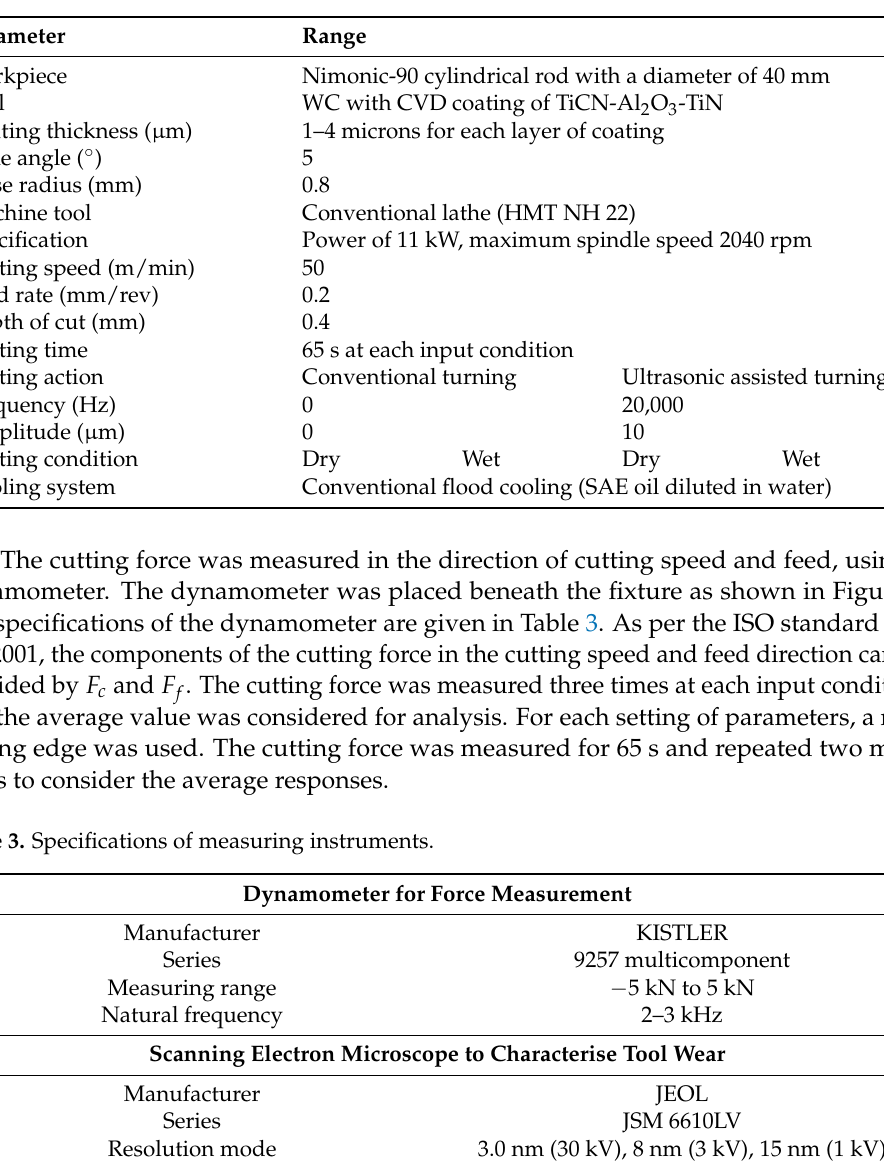
Table 2. Input process parameters for experimentation.